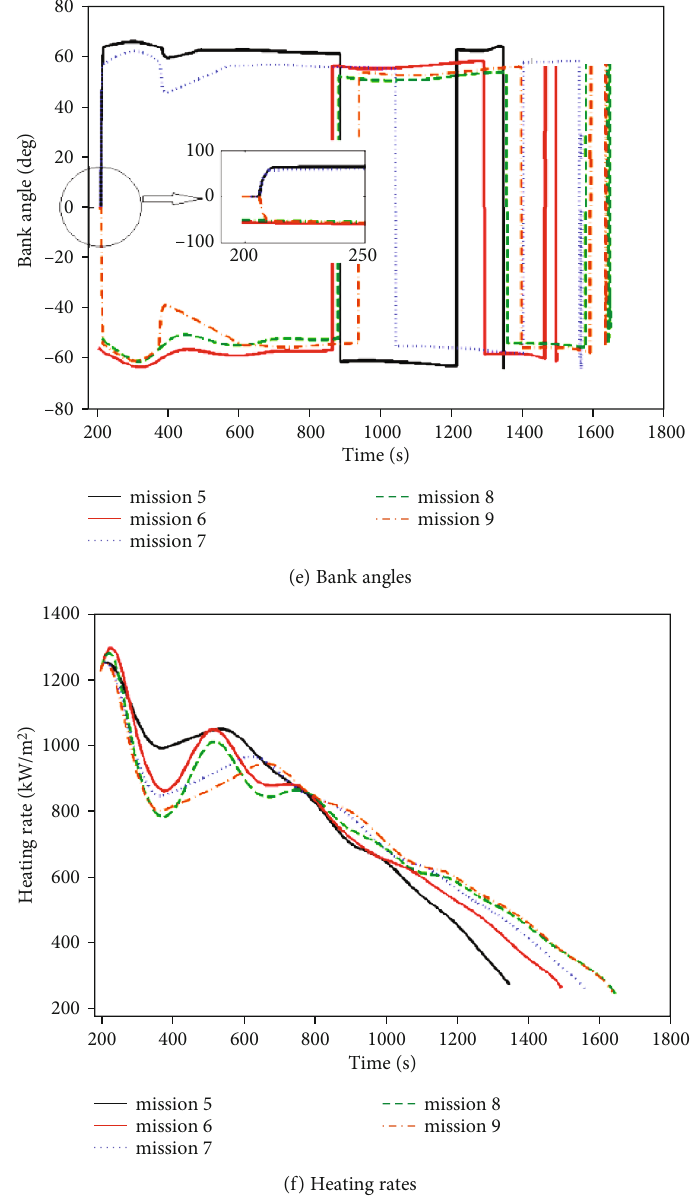
Figure 4: Trajectory comparison for all